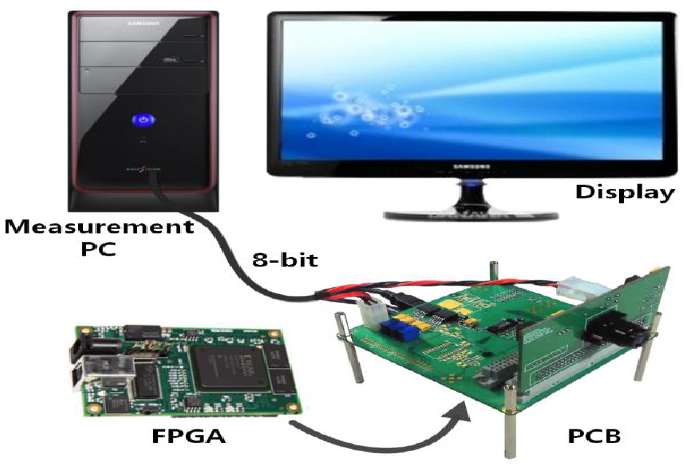
Figure 14. Configuration of measurement